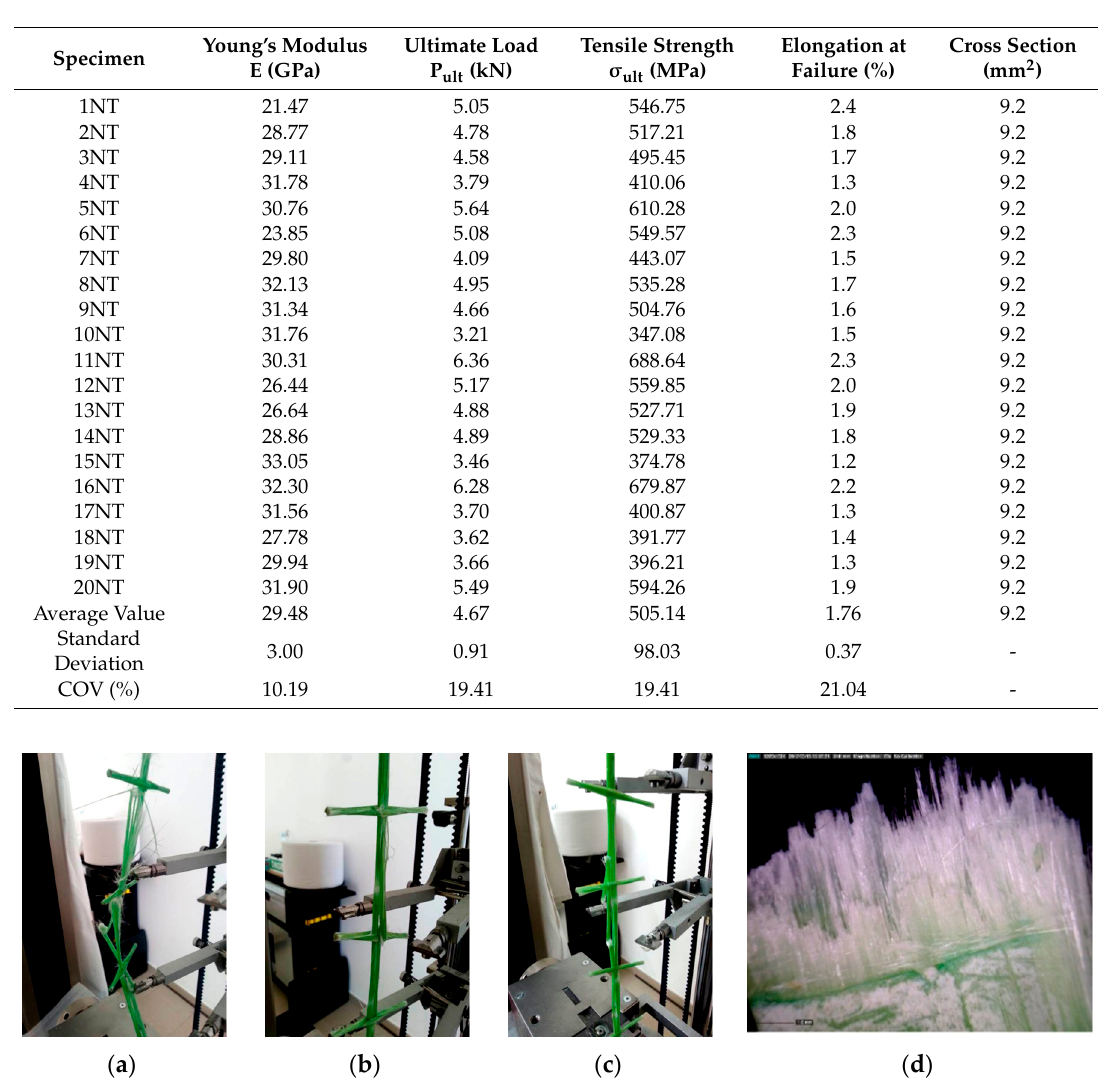
Table 3. Tensile tests results for unconditioned specimens.